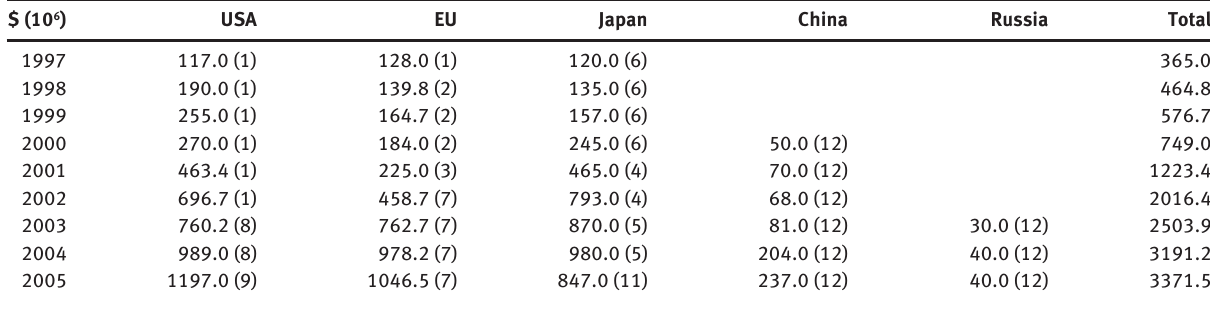
Table A1 Total expenditures in government funding on R&D in